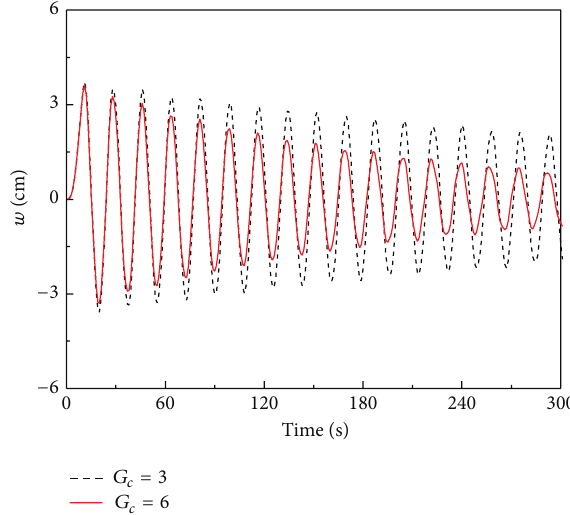
Figure 19: Acoustic pressure of the underwater structure when a positive electric potential is applied.